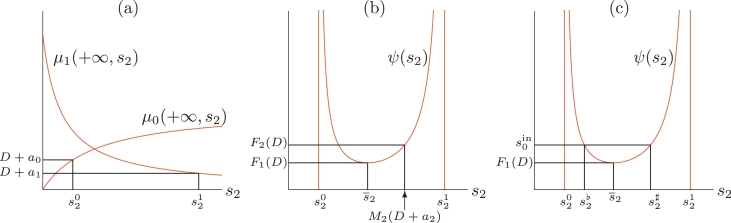
Graphical definitions. (a): s20 and s21. (b) : ψ(s2), s¯2,F1(D) and F2(D). (c): s2♭ and s2♯.